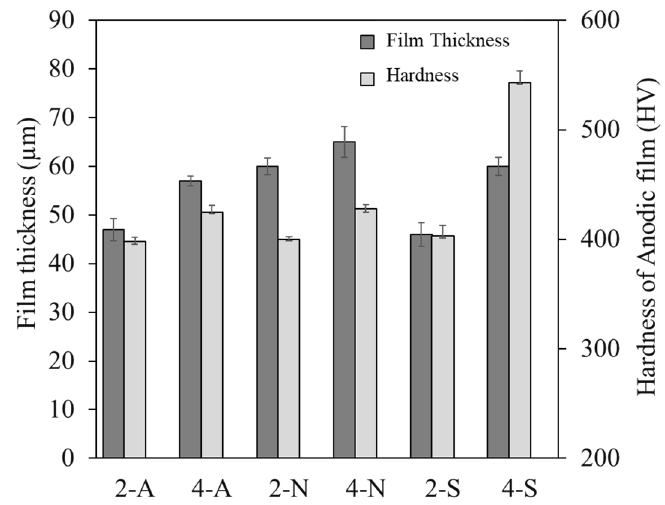
Figure 10. Film thickness and hardness of the anodic oxide layer on an A535 alloy. It can be seen that the film thickness of the 4-S sample that was treated for a